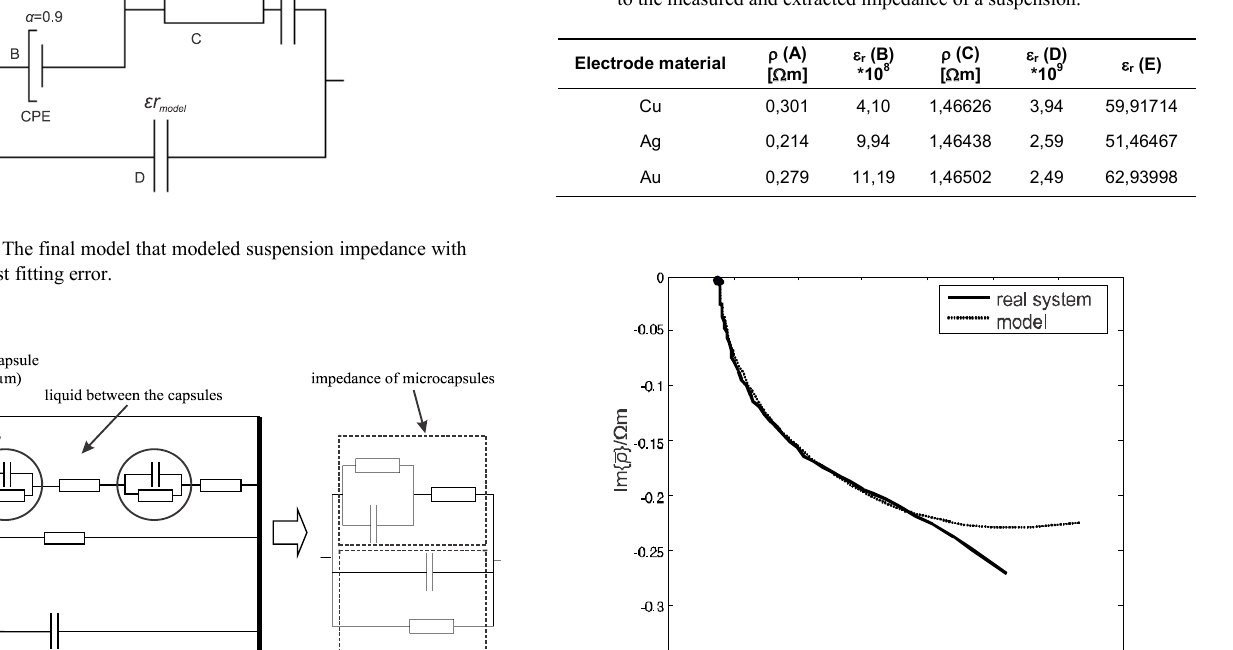
Table 1: Parameters extracted by fitting the model from Figure 7 to the measured and extracted impedance of a suspension.